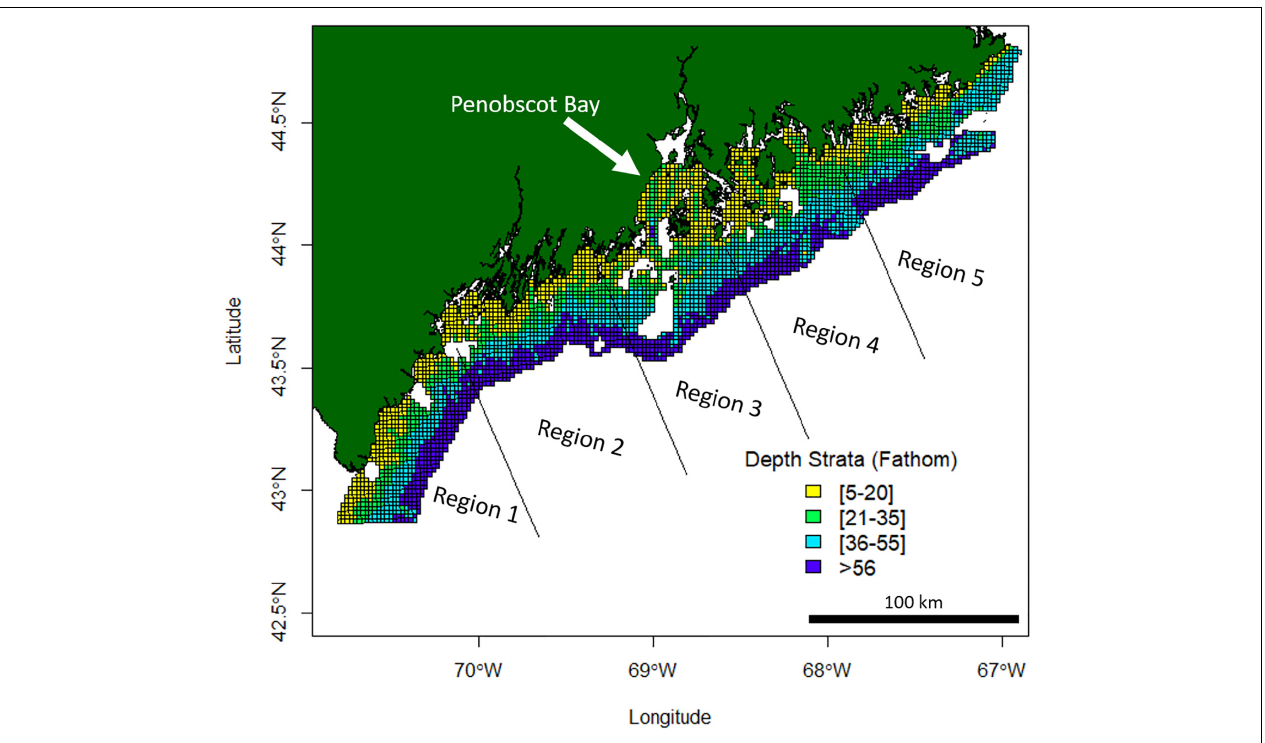
FIGURE 1 | Maine-New Hampshire Inshore Bottom Trawl Survey regions and depth strata. This survey is subdivided into five regions which include (1) New Hampshire and Southern Maine, (2) Mid-Coast Maine, (3) Penobscot Bay, (4) Mt. Desert Island, and (5) Downeast Maine. Missing white areas within the 12-mile survey grid area are non-surveyable locations due to the topography of the ocean floor at those